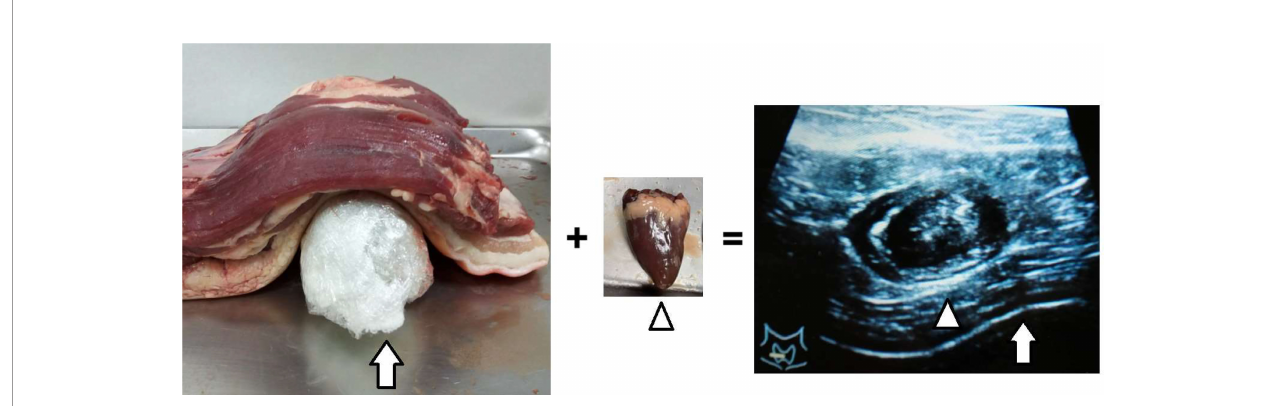
FIGURE 1 | Chicken hearts simulated into thyroid nodules (arrowhead), three-layer pork meats simulated into peri-thyroid skin structure, and gel bottles simulated into trachea